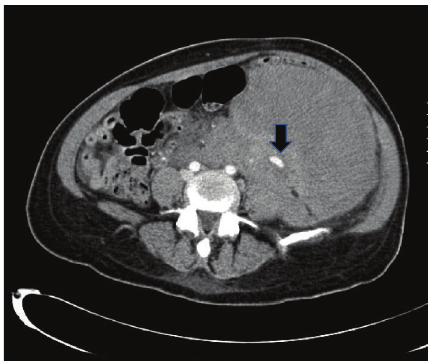
Figure 1: CT axial image with IV contrast: CT axial image of lower abdomen demonstrates 13mm × 70 mm aneurysm in the left lower quadrant associated with a large hematoma. This corresponds to the aneurysm in the selective left ovarian arteriogram in Figure 3 (arrow).